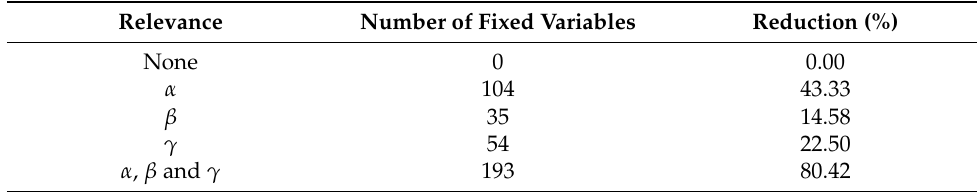
Table 7. Number of fixed variables.